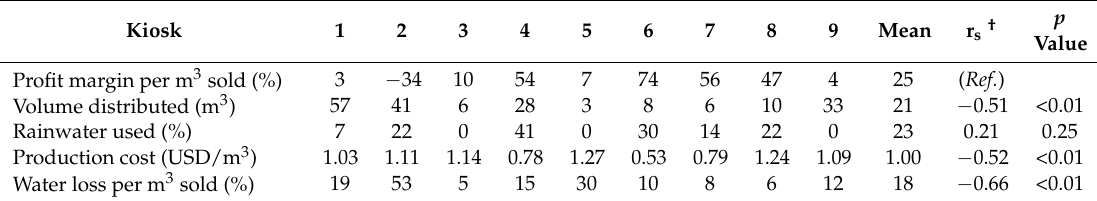
Table 3. Month Averages per Kiosk for Revenue, Profit Margin, Volume of Water Distributed, Production Cost, Water Loss and Measures of Correlation, for Nine Water Kiosks at Health Care Facilities in Rural Rwanda, 2013–2014. Kiosk 1